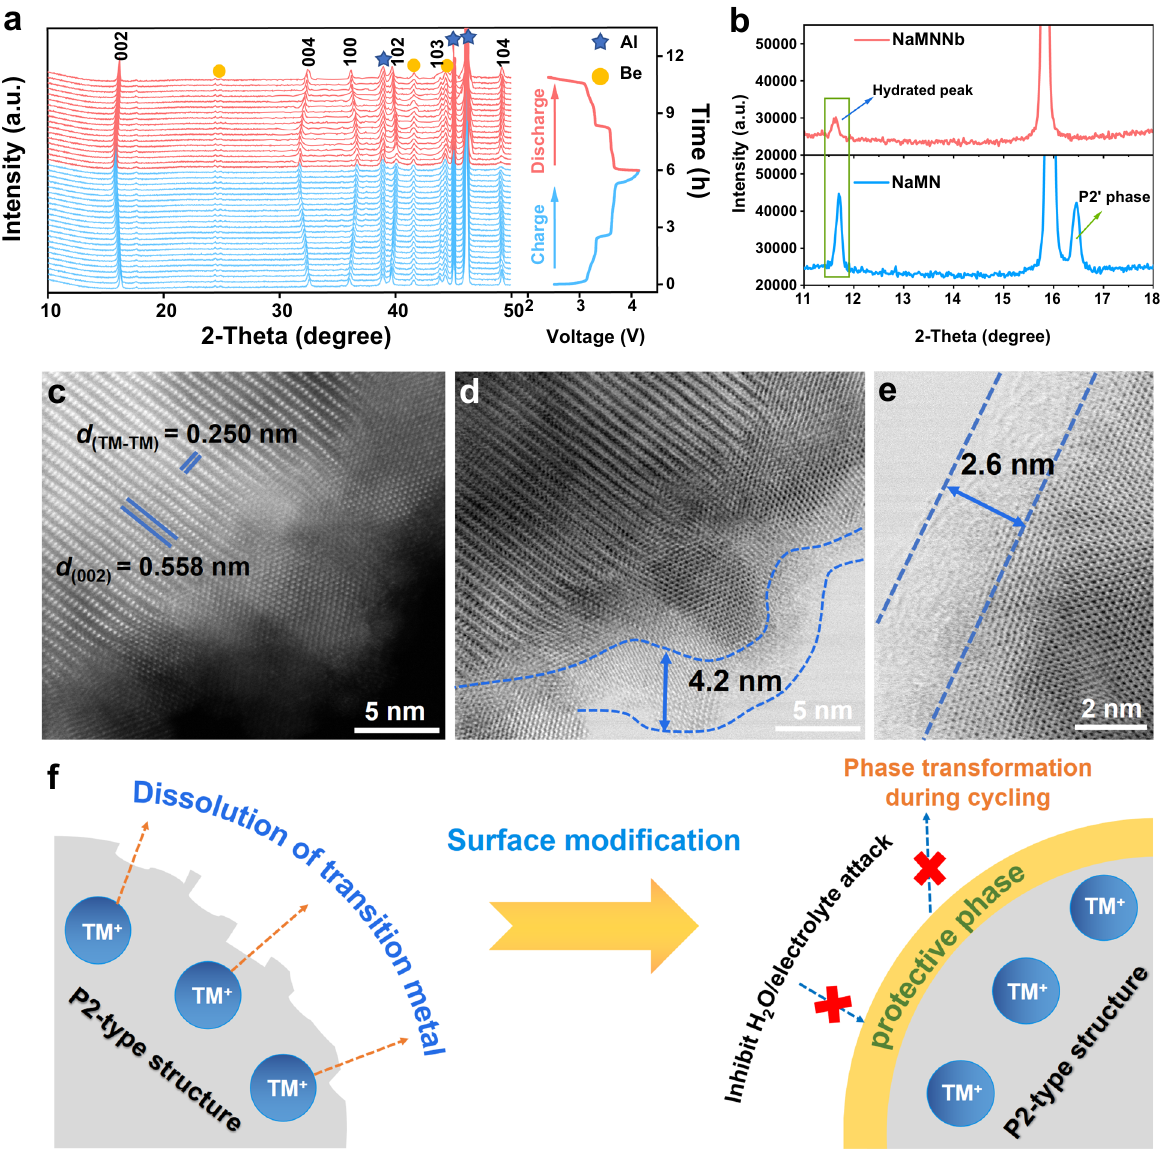
Fig. 5 In situ and ex situ structural characterizations of the P2-NaMNNb-based electrodes. a In situ XRD patterns using Swagelok cell corresponding to the charge and discharge curves between 2.4 – 4.15 V at 20 mA g − 1 and 25 °C. b Comparison of (002) diffraction patterns of ex situ XRD patterns of P2- NaMNNb and P2-NaMN after 30 cycles at 92 mA g − 1 . c The AC-HAADF-STEM image and d , e annular bright fi eld (ABF-STEM) images of the P2- NaMNNb after 30 cycles at 92 mA g − 1 and 25 °C in coin cell. f Schematic of the protective effect on the bulk